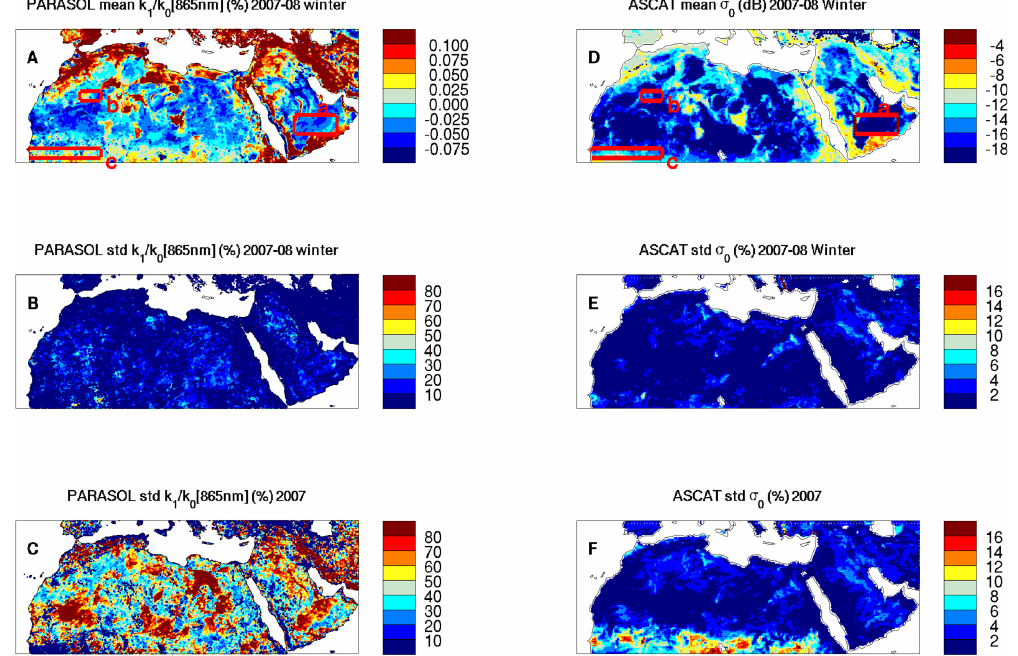
Fig. 1. Left panels: the PARASOL mean k 1 / k 0 at 865nm over the 2007-2008 winter months (A) , along with the variability of the k 1 / k 0 (calculated as the standard deviation over the mean k 1 / k 0 value in percentage) for the 2007–2008 winter months (B) and for the full 2007 year (C) . Right panels: same for the ASCAT σ 0 (D, E, F) . Three regions (a, b, c) are selected – on (A) and (D) – for a further analysis of the temporal variability (see Fig. 2). The regions cover the following areas: zone “a” from latitude 18 to 22, longitude 45 to 55, zone “b” from latitude 25 to 27, longitude − 5 to 0, zone “c” latitude 13 to 15, longitude − 17 to